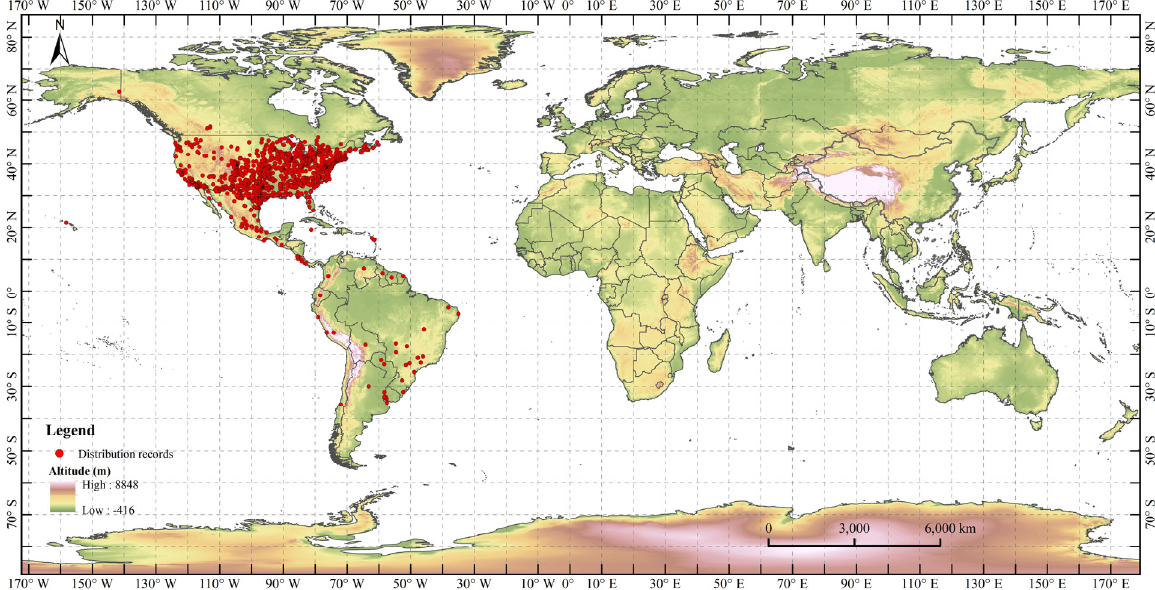
Figure 1. Distribution records of Helicoverpa zea included in MaxEnt model.